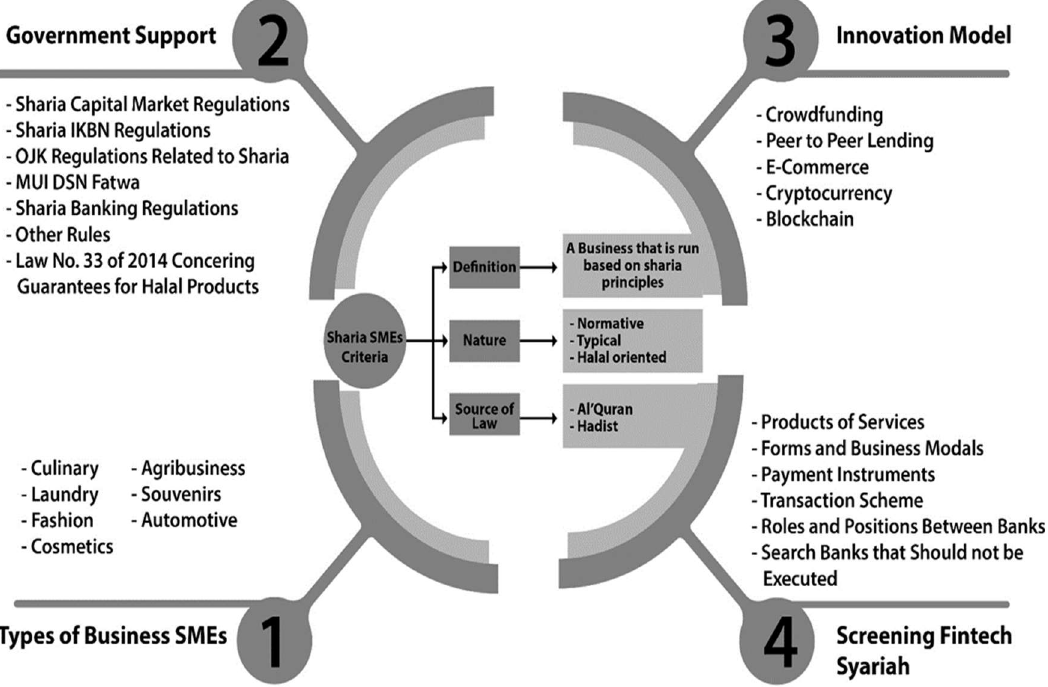
Figure 5. Sharia SMEs business criteria through government policy support. Source: Authors’ elaboration.